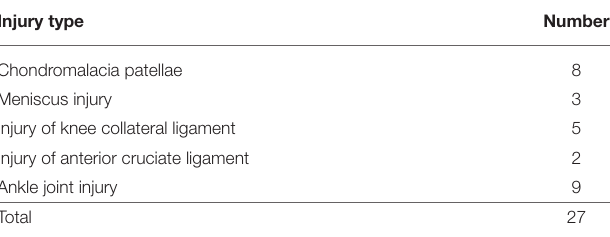
TABLE 1 | Non-patellar tendinopathy disorders or injuries in 3 years of follow-up. Injury